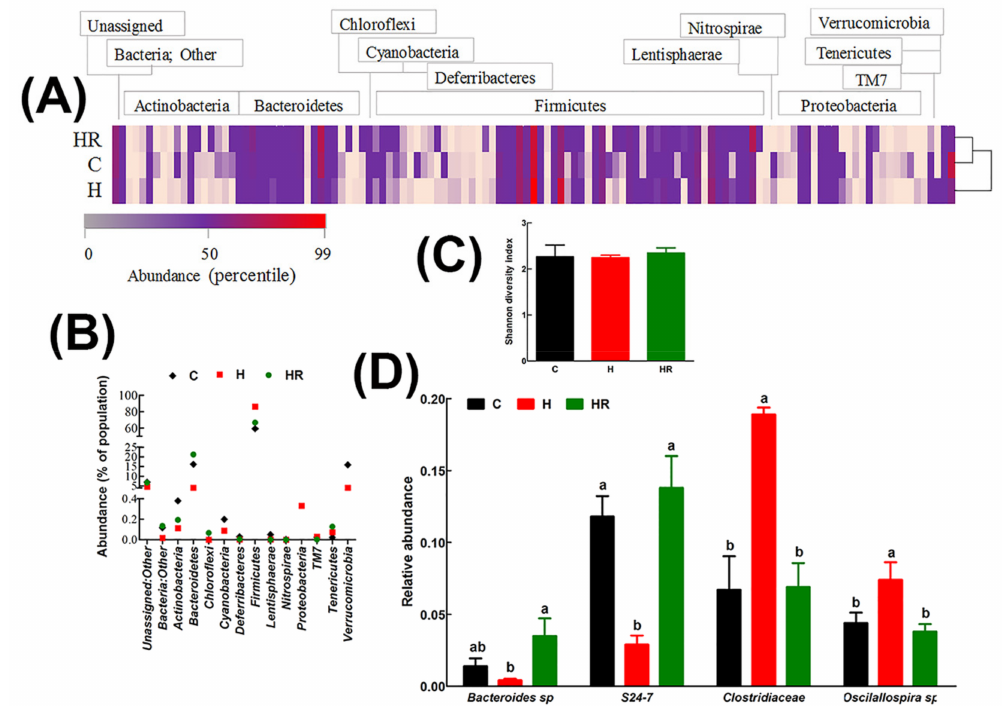
Figure 3. Effect of Kappaphycus on gut microbiota diversity profiles. ( A ) Heat map of bacterial species abundance. Abundance values for each species were plotted as a percentile with the most abundant species represented in bright red, the 50th percentile species represented in purple and the lowest value in pink. ( B ) The relative abundance of each phylum presented as a percentage of the total population for each treatment group. ( C ) Shannon diversity index. The index was determined from the means of abundance for each treatment group. ( D ) Relative abundance of species that were differentially regulated by diet. Only species whose mean abundance for the C diet group was equal to or higher than 1% were plotted in order to enhance confidence. C, corn starch diet-fed rats; H, high-carbohydrate, high-fat diet-fed rats; HR, high-carbohydrate, high-fat diet-fed rats supplemented with dried and milled whole Kappaphycus